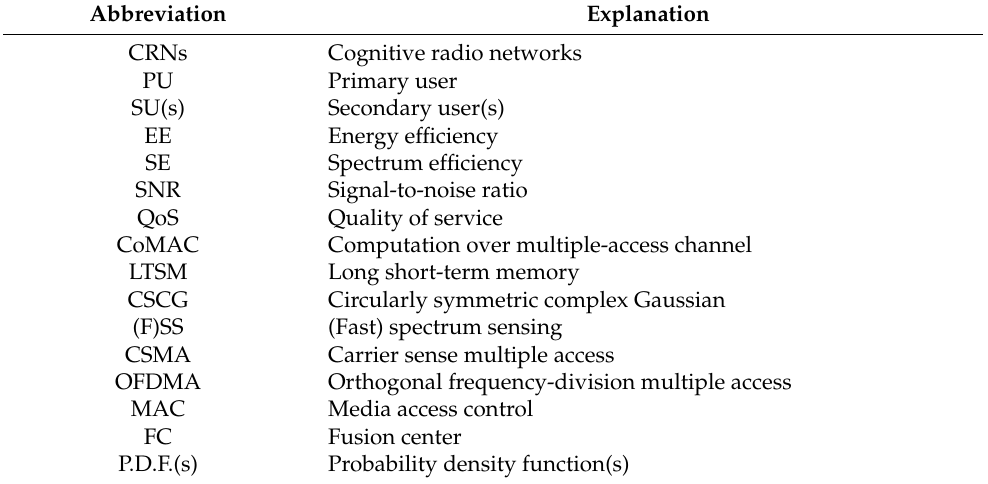
Table 1. Explanations for the abbreviations used in this